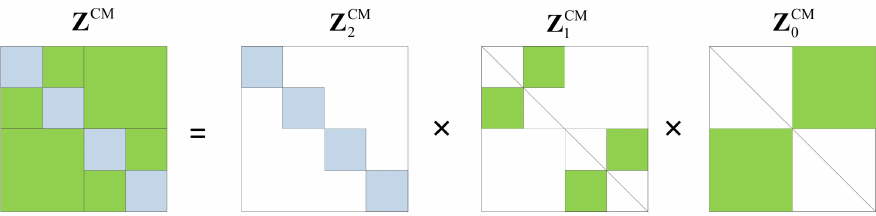
Figure 4. Schematic diagram of the block diagonal matrices in the two-level CM-SMWA algorithm.